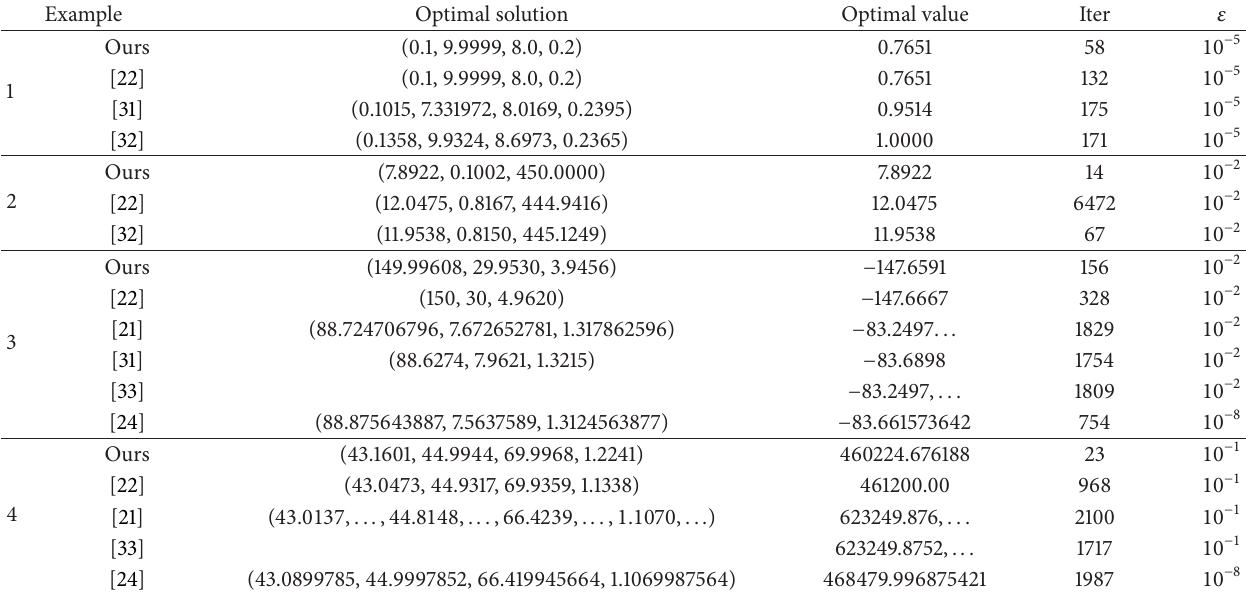
Table 1: The numerical results for Examples 1–4.